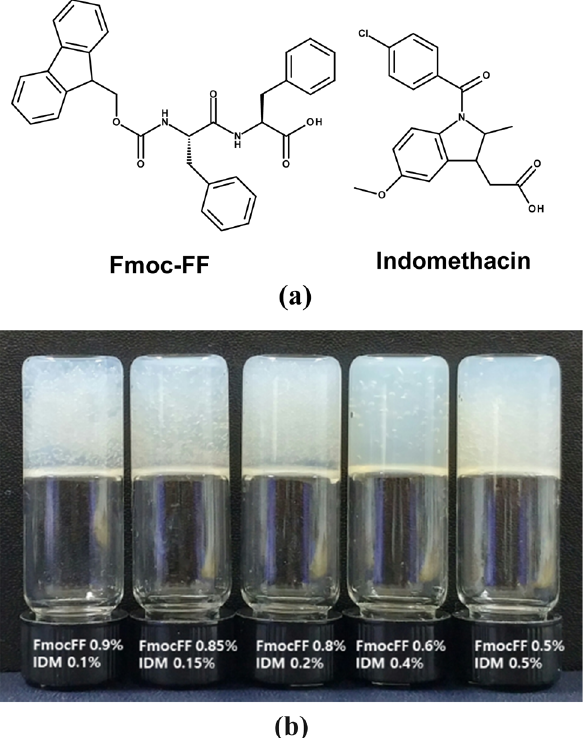
Figure 2: ( a ) Chemical structures of Fmoc - FF and IDM. ( b ) Photographs of Fmoc - FF – IDM hydrogels with varying ratios of Fmoc - FF/IDM.